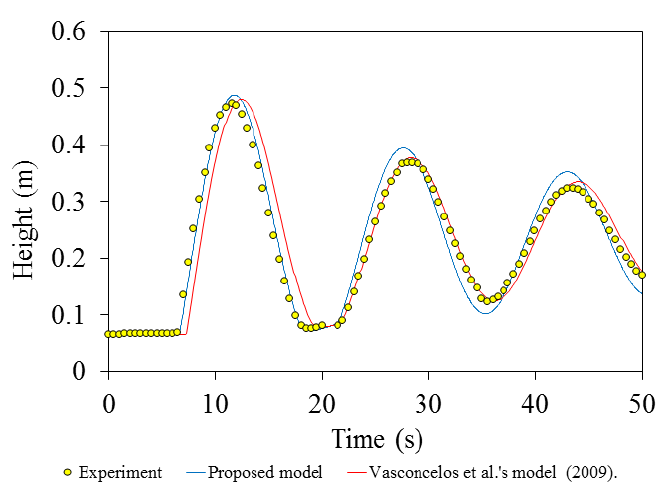
Figure 10. Water level time histories at the downstream tank.